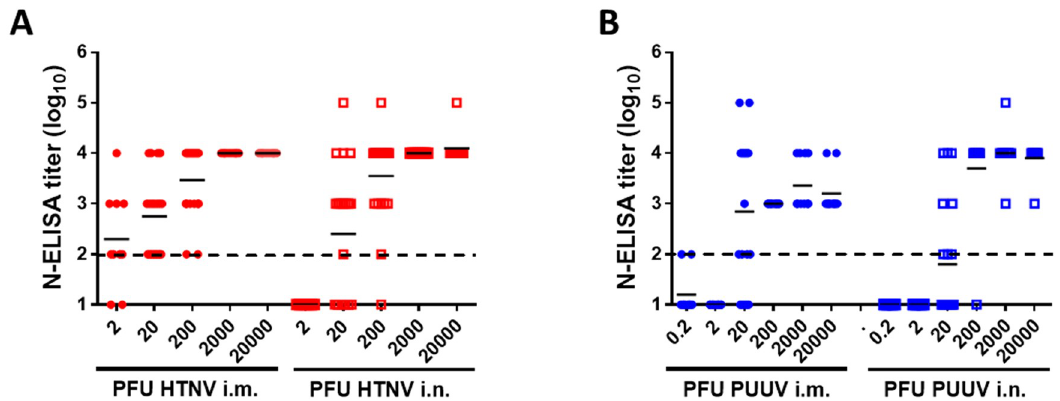
Fig 1. HTNV and PUUV infect hamsters in a dose dependent manner. Syrian hamsters were challenged with varying concentrations of either HTNV ( A ) or PUUV ( B ) through the i.m. (left) or i.n. (right) route. Between 28 and 35 days post infection hamsters were terminally bled and N-ELISA endpoint titers (log 10 ) were used to determine infection status. The mean titer is displayed for each group, and the limit of detection (2log 10 ) is depicted as a dashed line.